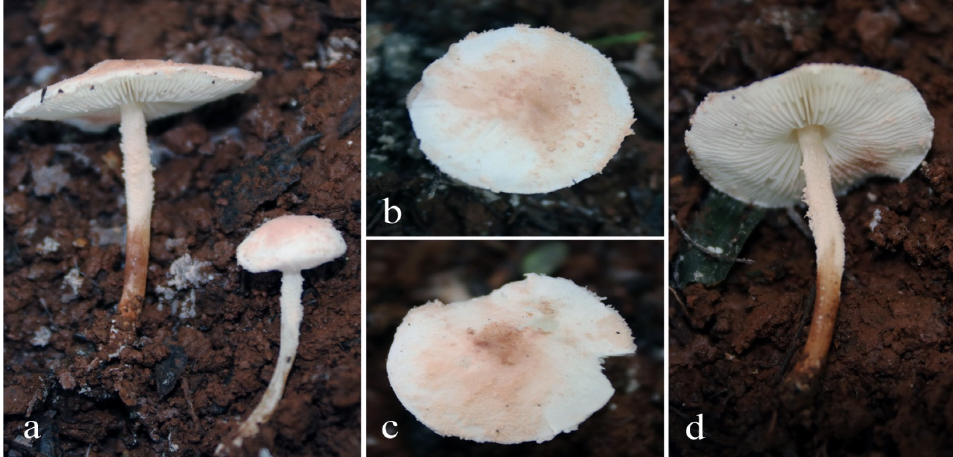
Figure 4 . Macrocharacters of Cystolepiota thailandica . ( a , b ) = MFLU22-0017 (holotype), ( c , d ) = MFLU22-0018 (paratype).